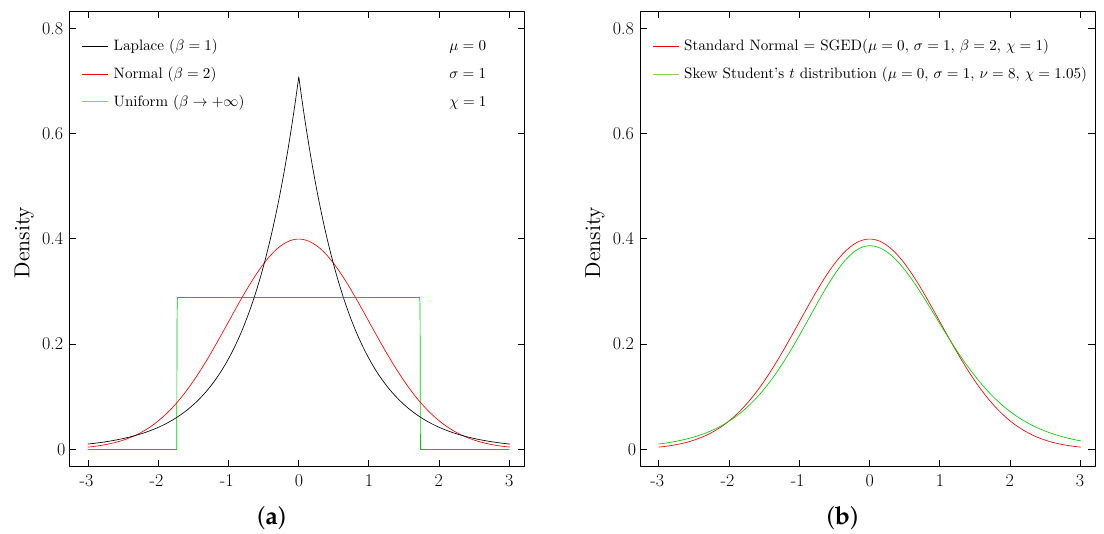
Figure 2. An SGED ( µ , σ , β , χ ) and a skew Student’s t distribution. Notes : In ( a ), we show special + ∞ which correspond to Laplace (black), cases of the shape parameter β = 1, β = 2, and β → Standard Normal (red), and Uniform (green) distributions, respectively. In ( b ), we include a skew Student’s t distribution with degrees of freedom equal to 8, i.e., ν = 8. It is skewed to the right because the skewness parameter exceeds 1, i.e., χ > 1. ( a ) Special cases of SGED; ( b ) normal and skew Student’s